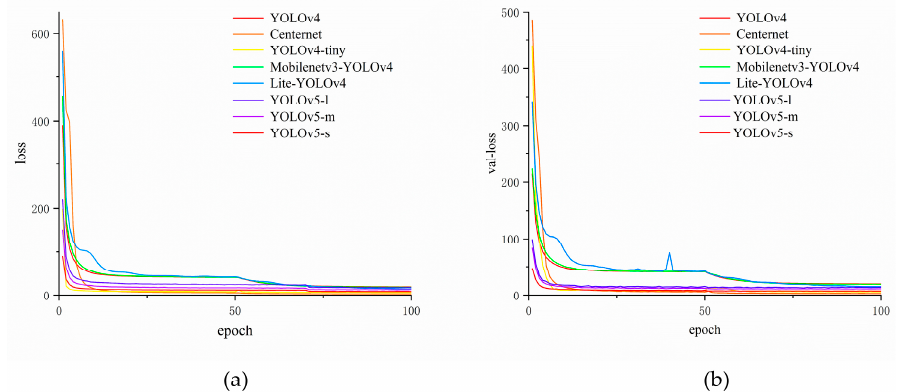
Figure 6. Model loss function plot. ( a ) Comparison curve of the loss function of the training set. ( b ) Validation set loss function contrast curves.